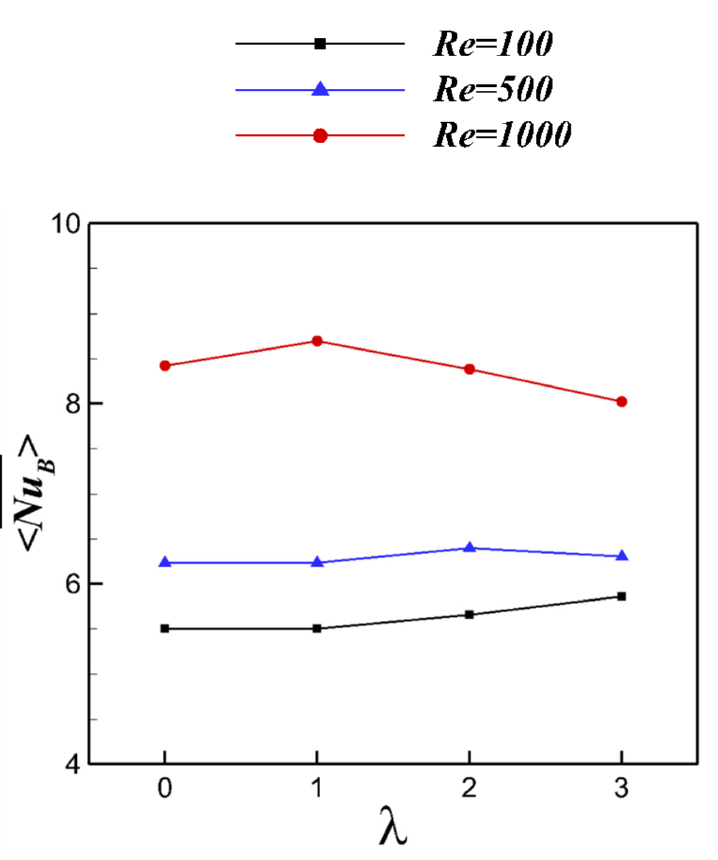
Figure 9. Distribution of time- and surface-averaged Nusselt number for the heated bottom wall as a function of wavelength.